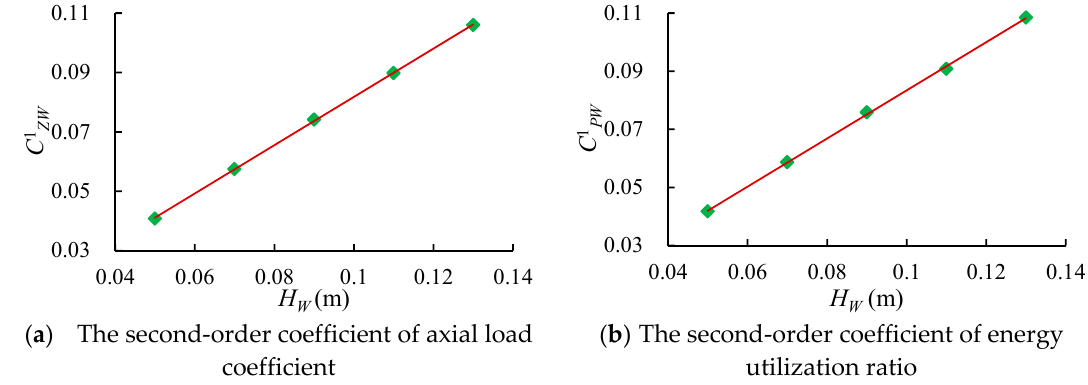
C and 1 C ) curve with wave height. Figure 11. The first-order coe ffi cient ( C 1 and C 1 ) curve with wave PW ZW ZW PW